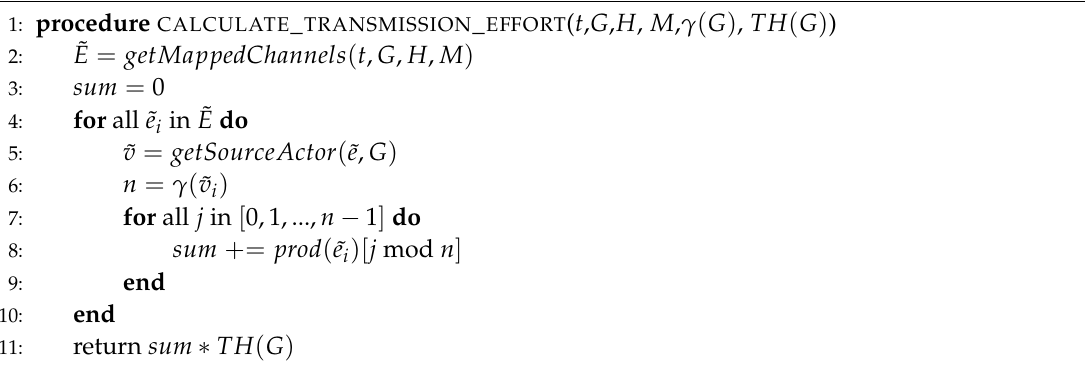
Algorithm 2 Calculating effort function e f trans ( t ) , capturing the amount of transmission on hardware channel t